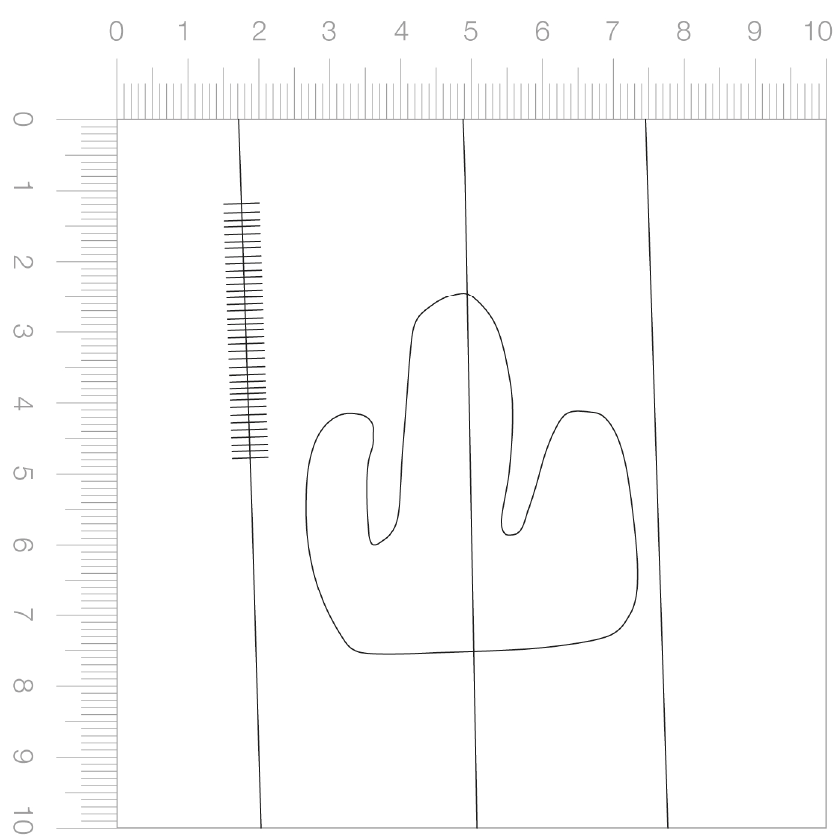
Figure A1. Watermark design diagram. Digital retracing of the main lines of the paper mould of the sheet RCIN 912518. Reproduction according to the verso side of the folio, likely the mould side of the paper sheet. Created by author.